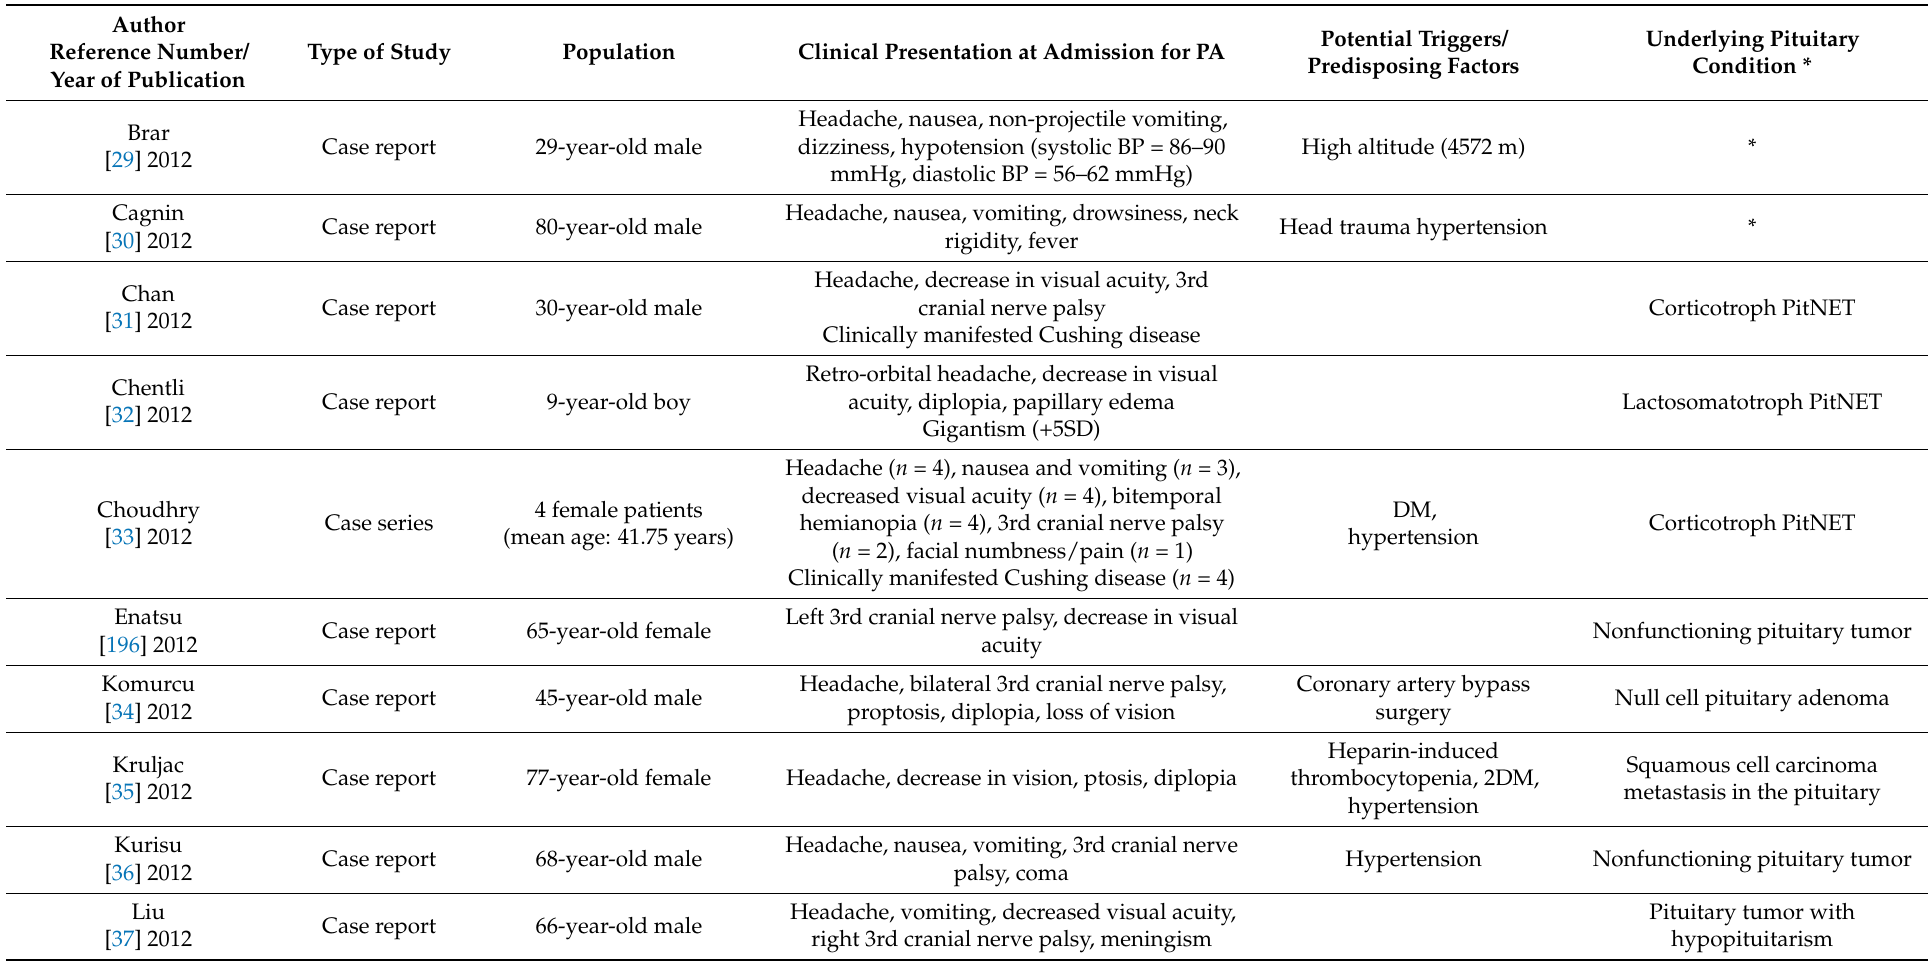
Table 1. Original studies published between 2012 and 2022 concerning PA according to our methodology; the cited studies are displayed from 2012 to 2022; the data concern the clinical presentation and potential triggers of PA in addition to underlying pituitary disease (if any)